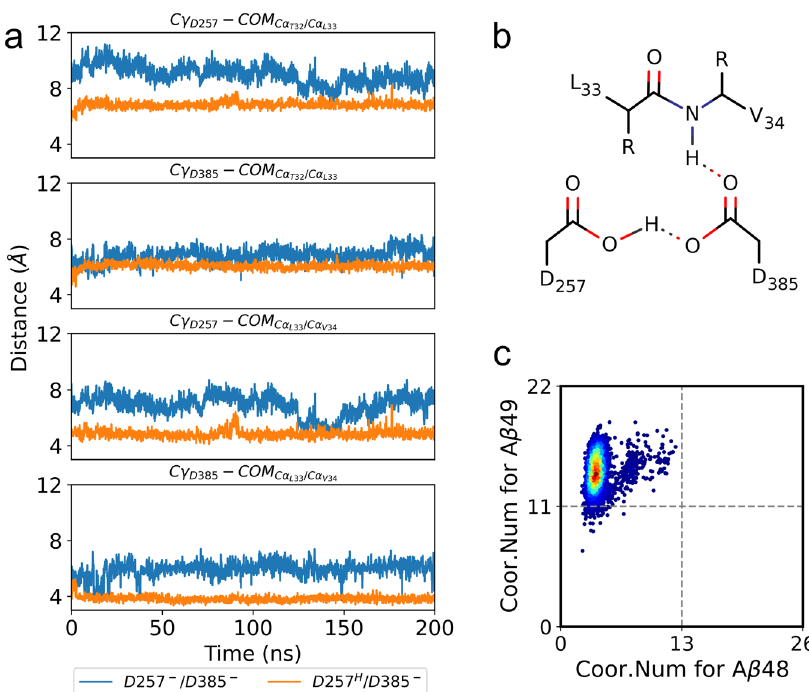
Fig. 5 The con fi gurations of catalytic core are altered by the protonated states of D257 and D385. a Time evolution of the distance between the C γ atom of D257/D385 and the COM of the C α atom in T32-L33 or L33-V34 under two protonation states. b The stable con fi gurations of the catalytic core for A β 49 production. c The formation of coordination between PS1 and scissile bonds in T32-L33 (for A β 48 cleavage) or L33-V34 (for A β 49 cleavage) at the catalytic core.